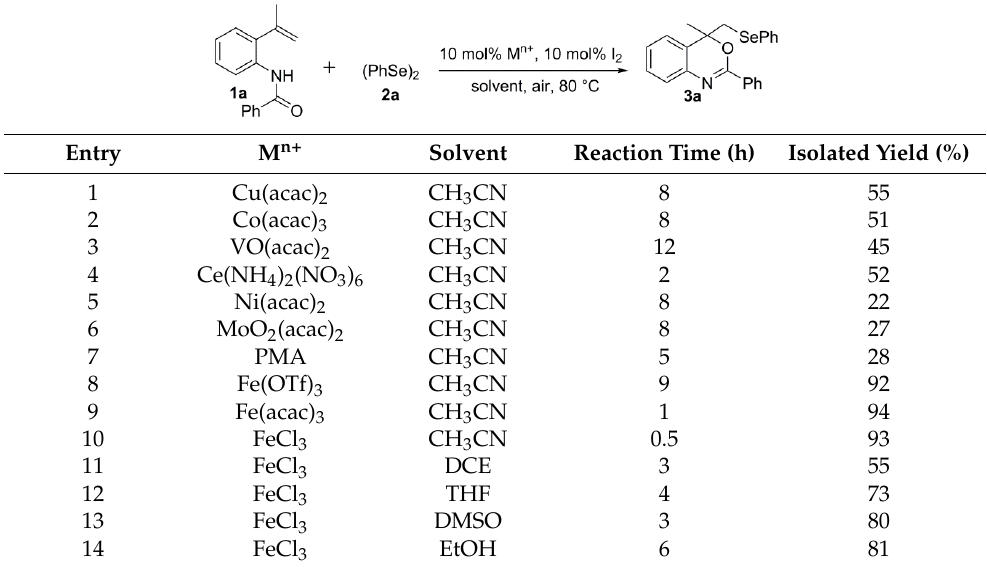
Figure 2. Previous and current selenocyclization methods.